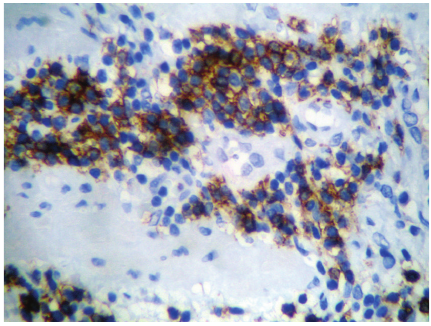
Figure 4: Immunohistochemistry ( ×400 ) showing CD20 positive small